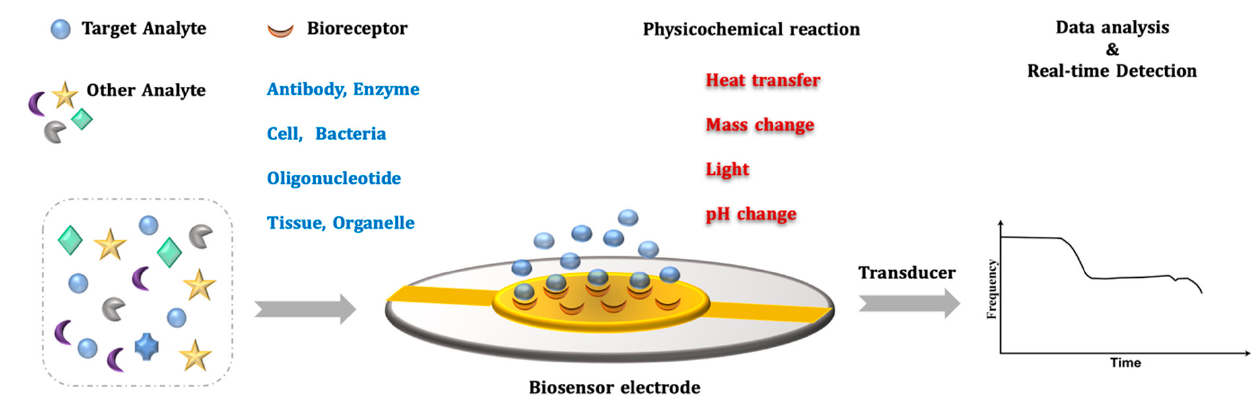
Figure 2. Working principle of a biosensor.